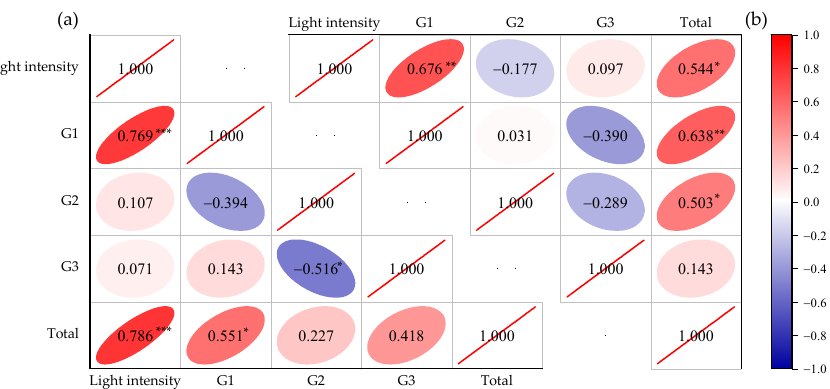
Figure 5. Correlation analysis between light intensity and phototactic response rate of adults. ( a ) females; ( b ) males. * significant at p < 0.05 level, ** significant at p < 0.01 level, *** significant at p < 0.001 level by Pearson correlation